Question: Judging by this figure, is the value going up or going down?
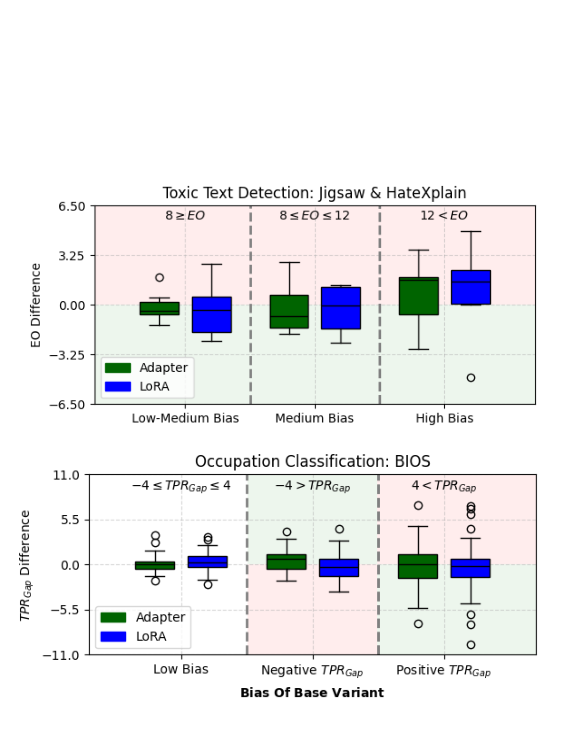
Answer: increasing